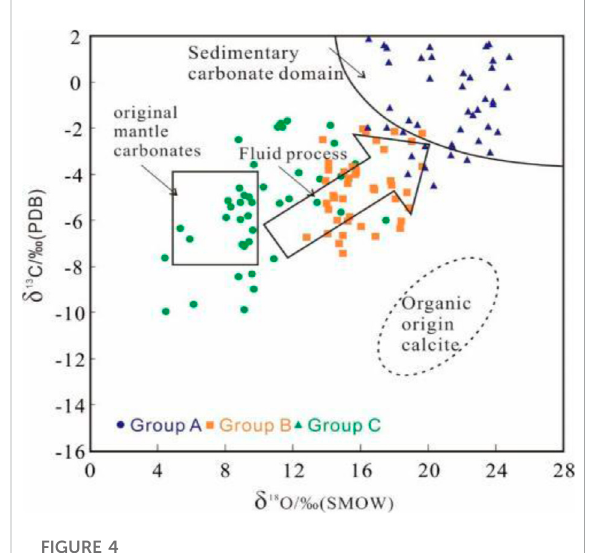
FIGURE 4 C-O isotope diagram for calcite cements in the tectonic fractures of the Lucaogou Formation in the Jimsar Sag, Junggar Basin. Data of original mantle carbonate were from Taylor et al. (1967) and Hoefs and Hoefs, (2009); data of sedimentary carbonate were from Veizer and Hoefs, (1976) and Toyoda et al. (1994) data of mantle carbonate of South India were from Wickham et al. (1994); data of calcite cements, limestone and sandstone of Dongying Sag were from Jin and Wang, (2007).